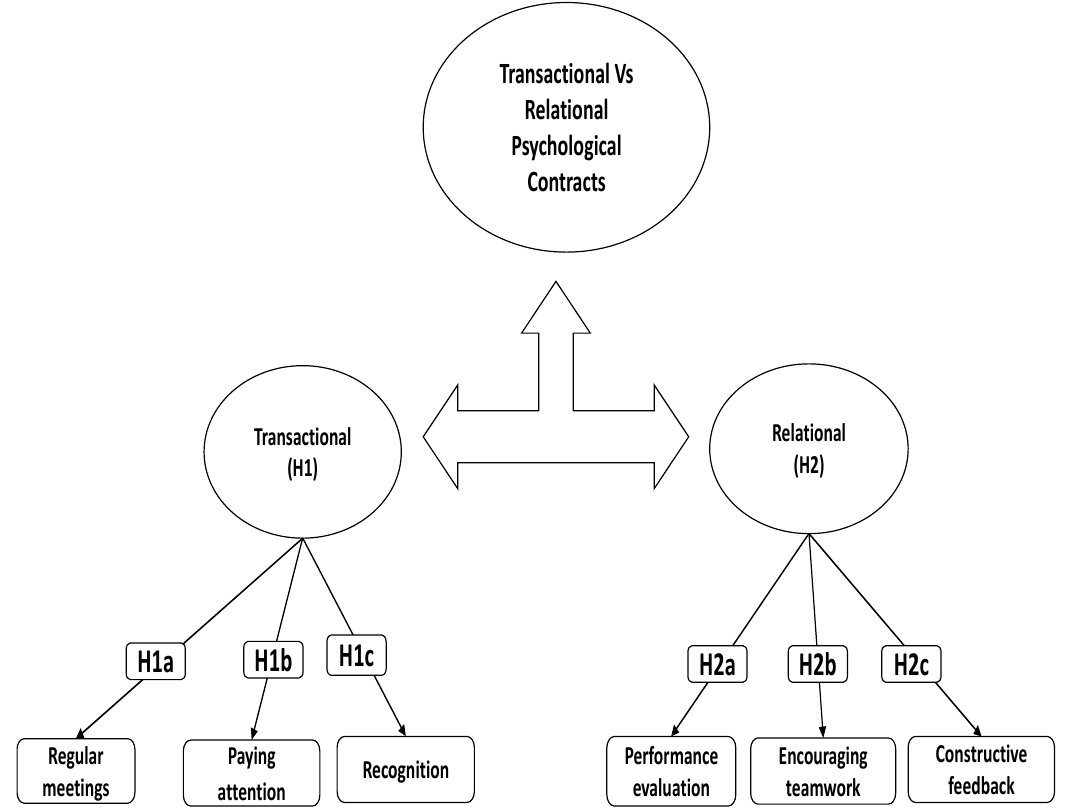
Figure 1. Hypothesis on the transactional vs. relational psychological contracts.